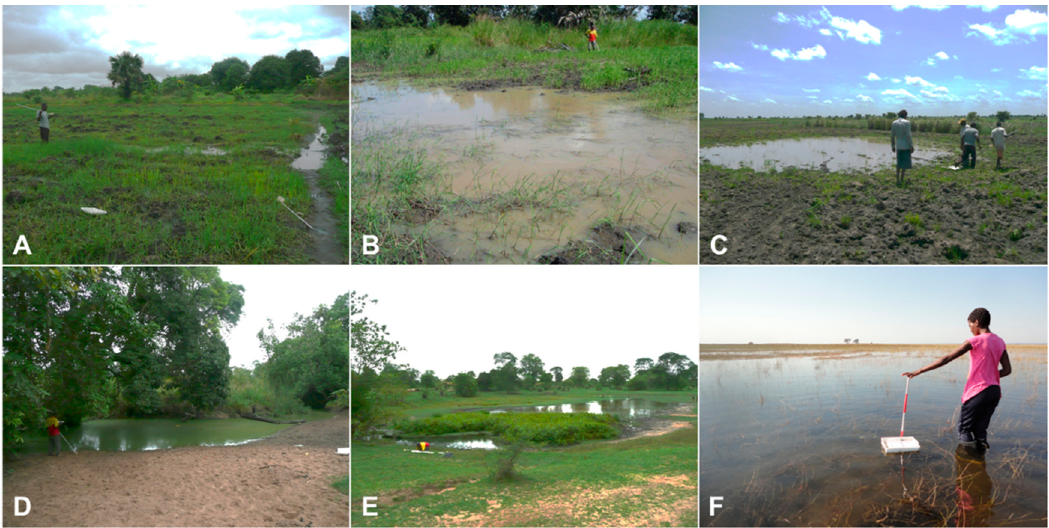
Figure 1. Example malarial mosquito aquatic habitats including ( A ) saturated areas driven by topographic convergence of subsurface moisture; ( B ) depressions within floodplains of active river channels with well-developed levees; ( C ) water bodies within relict palaeochannel systems; ( D ) pools located in perennial or seasonally active river channels; ( E ) spring-fed pools; and ( F ) river flood inundation zone. Images A-E taken within a malaria endemic area in Tanzania, from Hardy et al. [35] and F in Zambia. Each site contained malaria vector